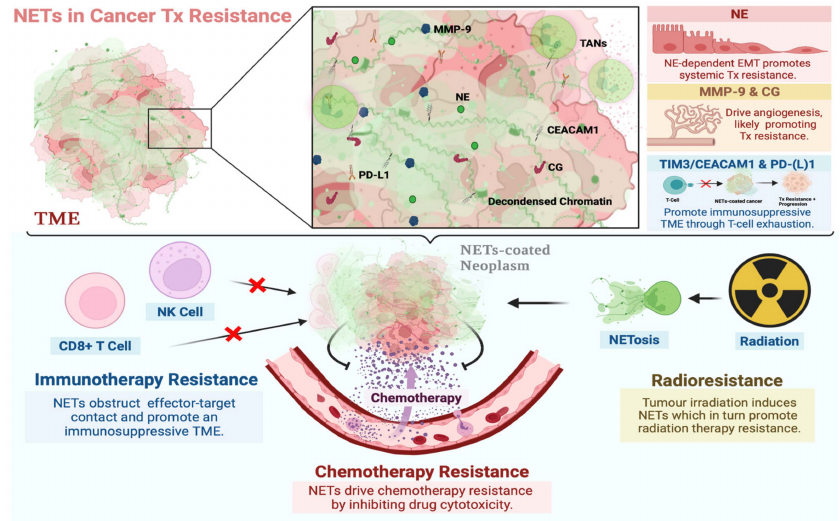
Figure 1. Involvement of NETs in resistance to systemic and local cancer therapies. NETs are DNA webs extruded by neutrophils and associated with NE, MMP-9, CG, CEACAM1, and PD-L1 proteins, among others. These proteins are known to drive mechanisms associated with neoplastic resistance to systemic and local therapies. NETs may promote a microenvironment that favors the development of such a phenotype by sequestering tumor cells, bringing them into contact with these proteins, and driving multiple mechanisms of resistance concurrently. The functional role of NETs in resistance to chemo-, immuno-, and radiation therapy has been reported [61,76,77,81,128]. Proposed mechanisms thereof include NETs coating neoplasms and preventing contact with cytotoxic immune cells, T-cell exhaustion through CEACAM1/TIM-3 interactions and the PD-1/PD-L1 axis, drug detoxification, angiogenesis through CG and MMP-9 activity, and NE-dependent EMT, among others. Created with BioRender.com (accessed on 28 January